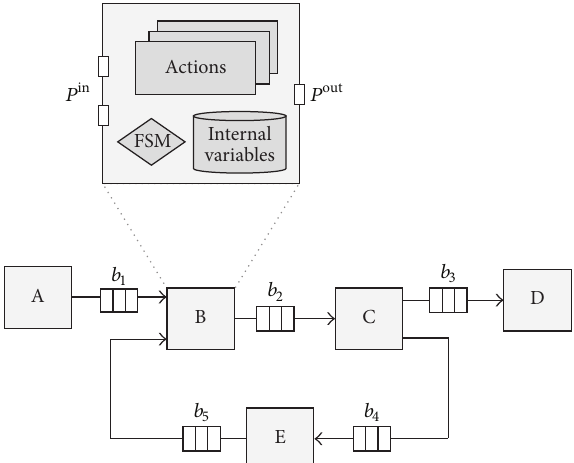
Figure 1: Construction of a sample dataflow program.